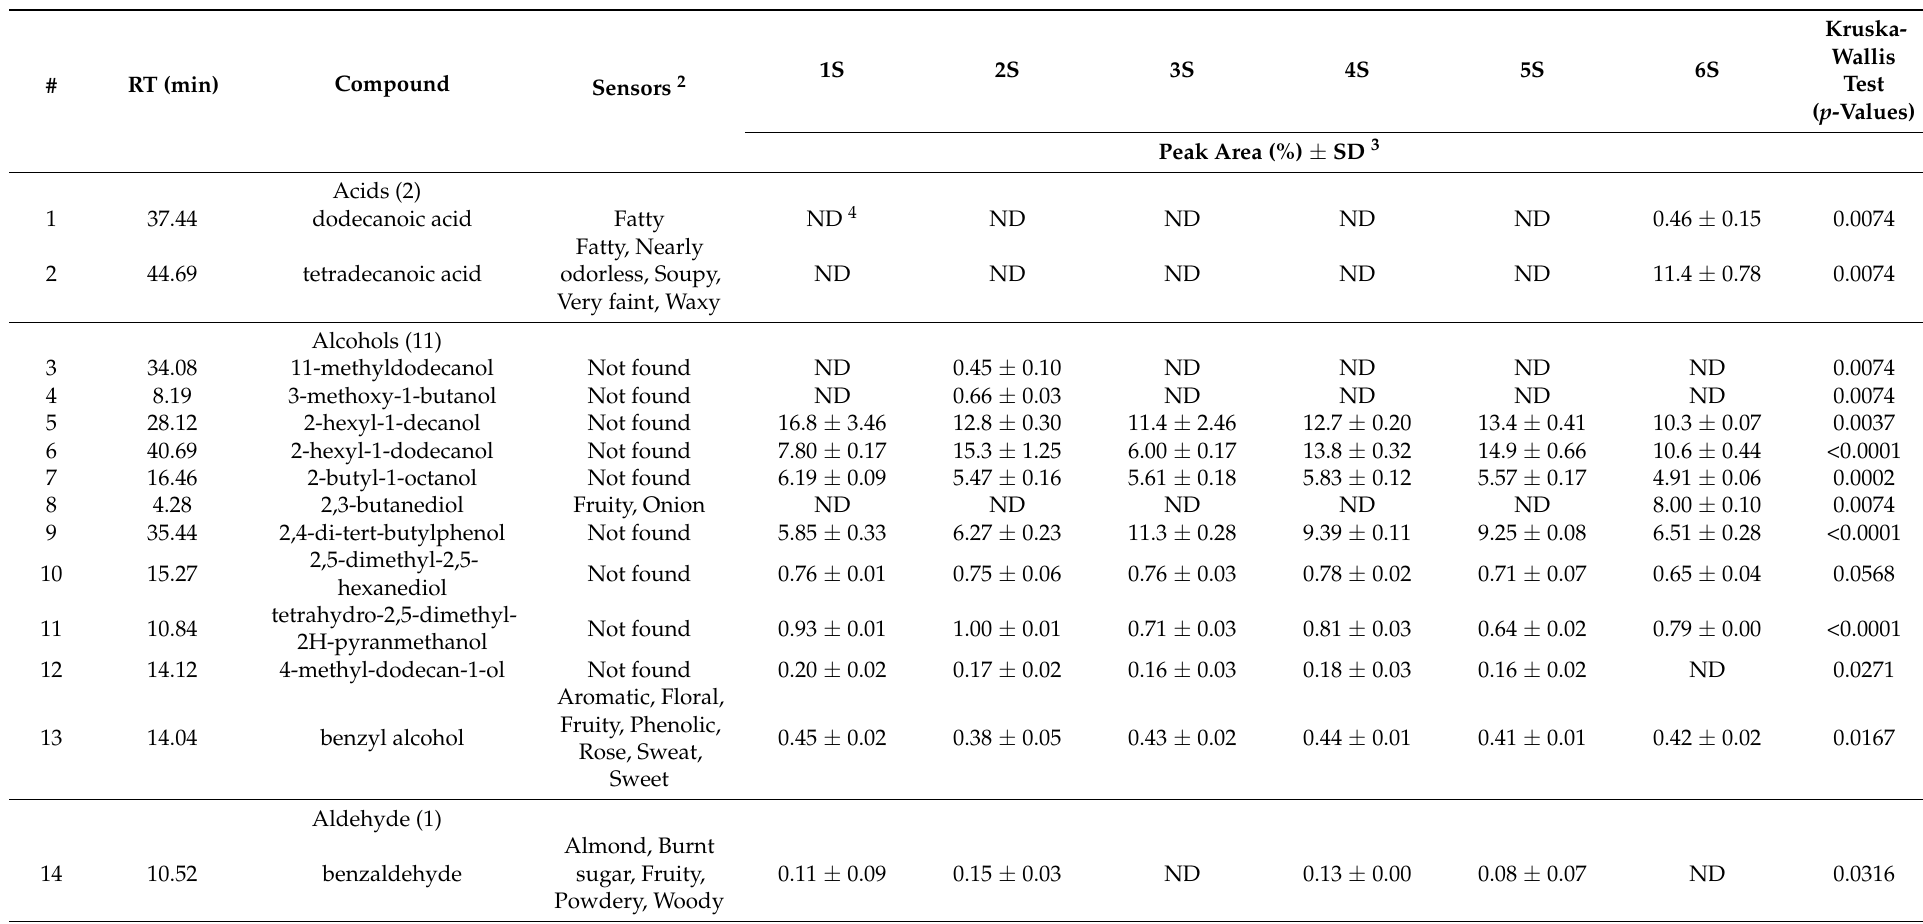
Table 2. Relative percentage (%) of volatile compounds identified in the dichloromethane extract of the Amanita rubescens stipes (1–6S) 1 at various developmental stages by the gas chromatography-mass